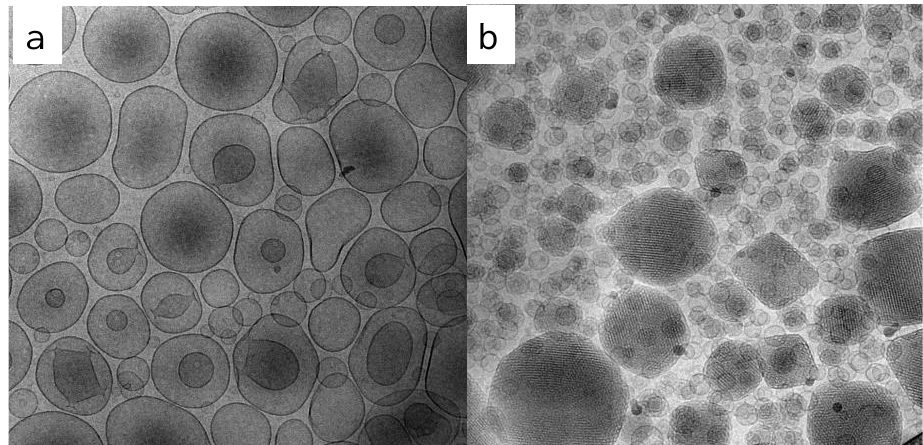
Figure 6. Cryo-TEM images of MAD obtained with hydrotrope ( a ) or hot homogenization ( b ) method in the presence of poloxamer 407 as surfactant.